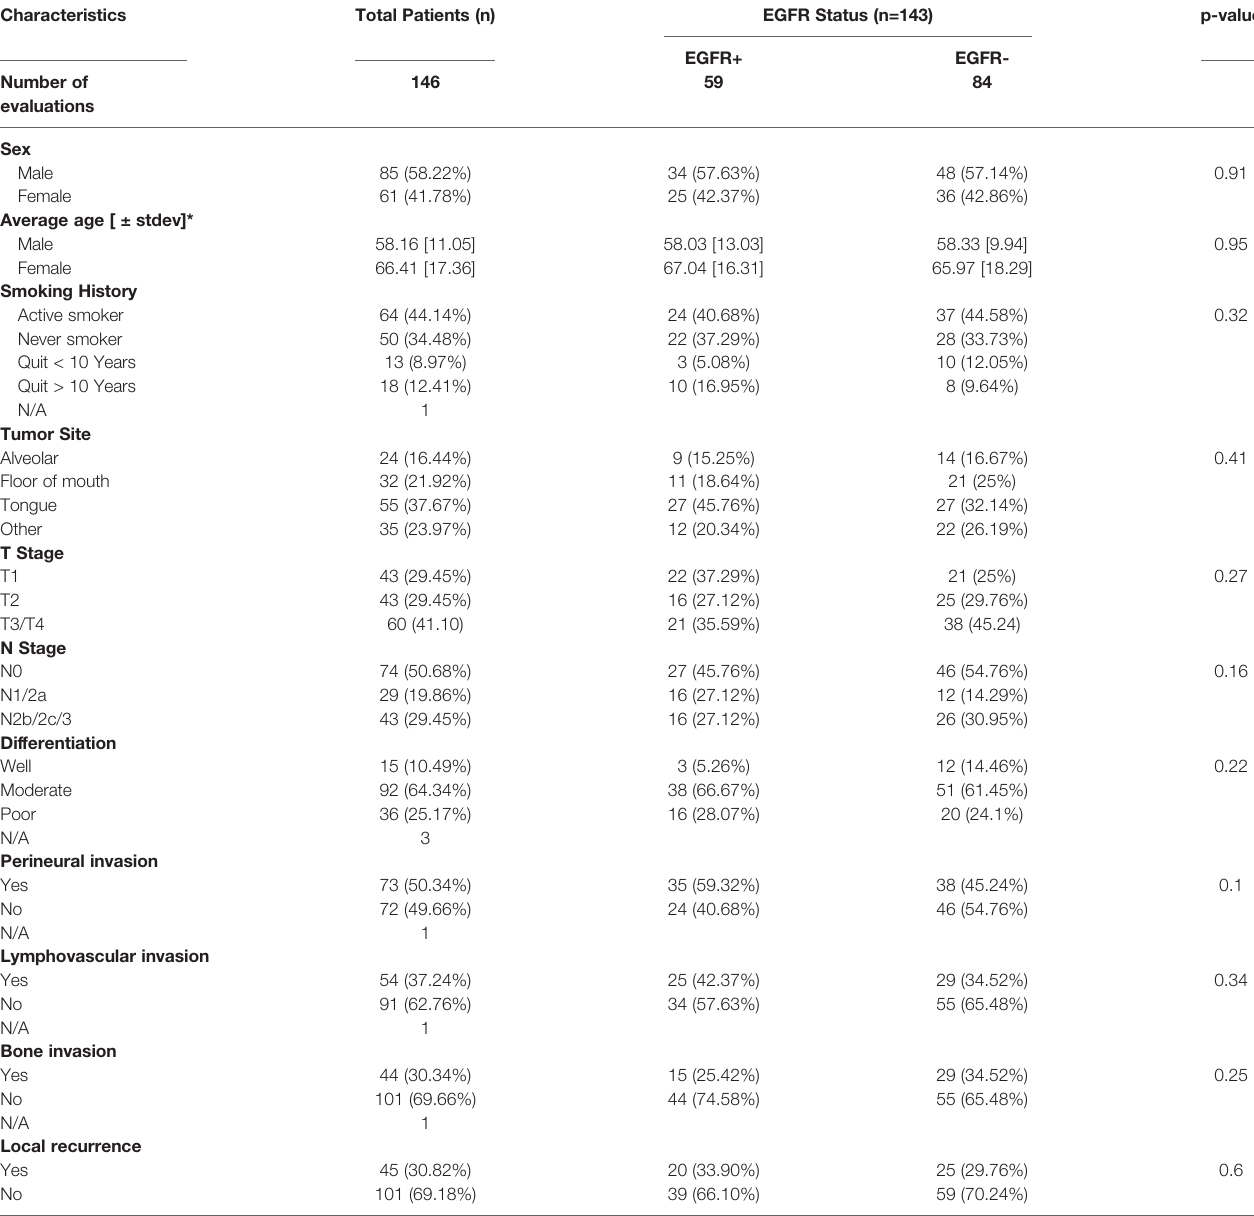
TABLE 1 | Clinicopathological features of patients based on EGFR